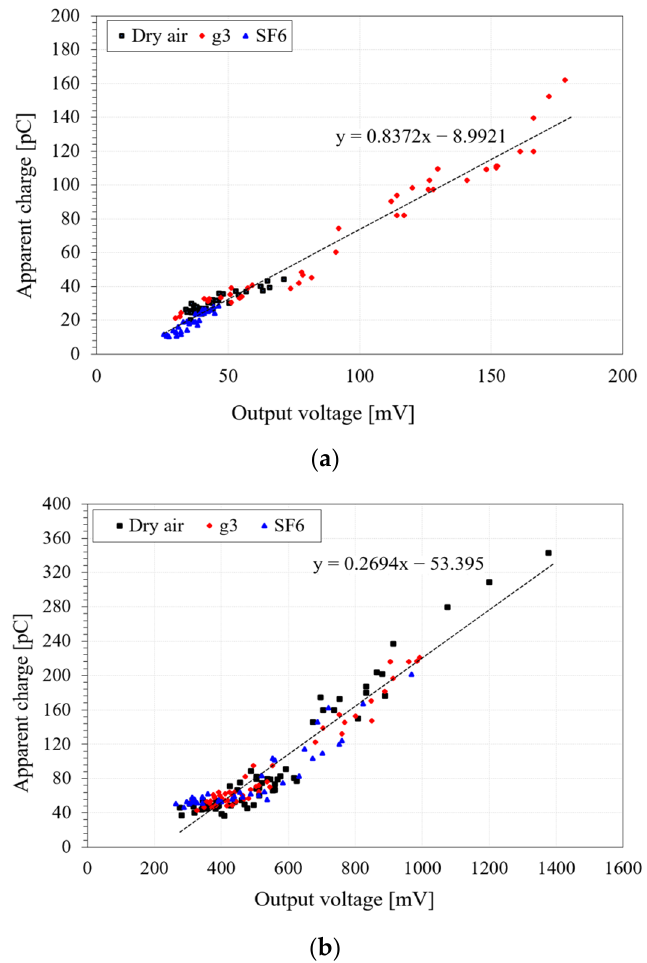
Figure 8. Correlation between output voltage in mV and apparent charge in pC: ( a ) in POC and ( b ) FMP.